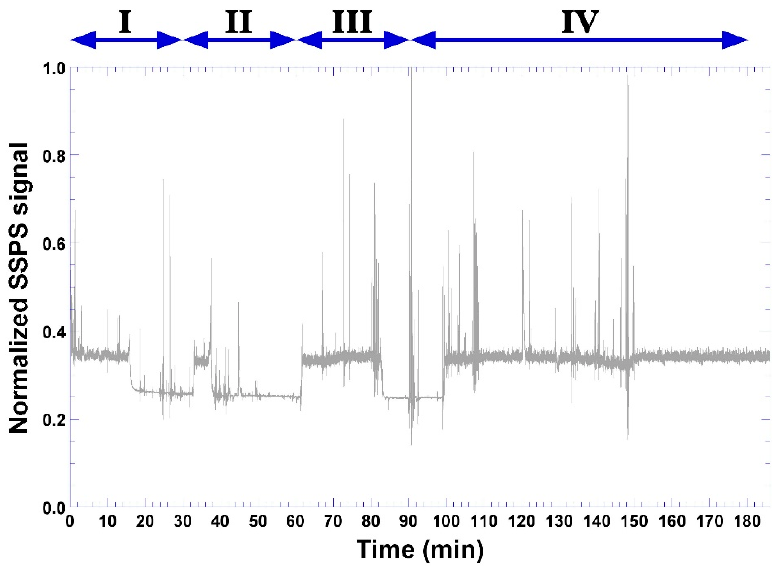
Figure 13. Evolution of the normalized solid-state photosensor signal throughout the bioreaction timeframe using the bioluminescent hydrogel in bio-detection system